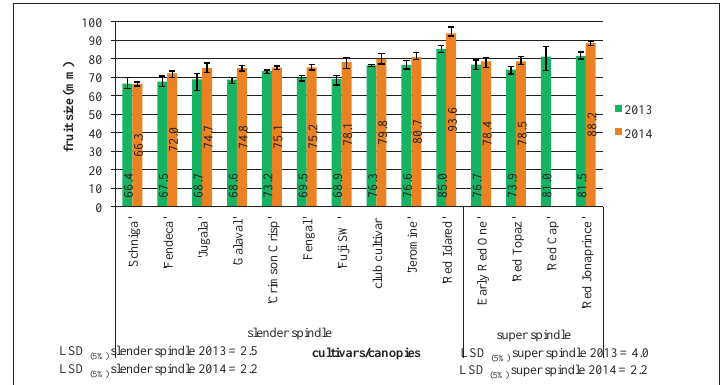
Figure 4: Fruit size of the cultivars (Nyírbátor, 2013–2014)